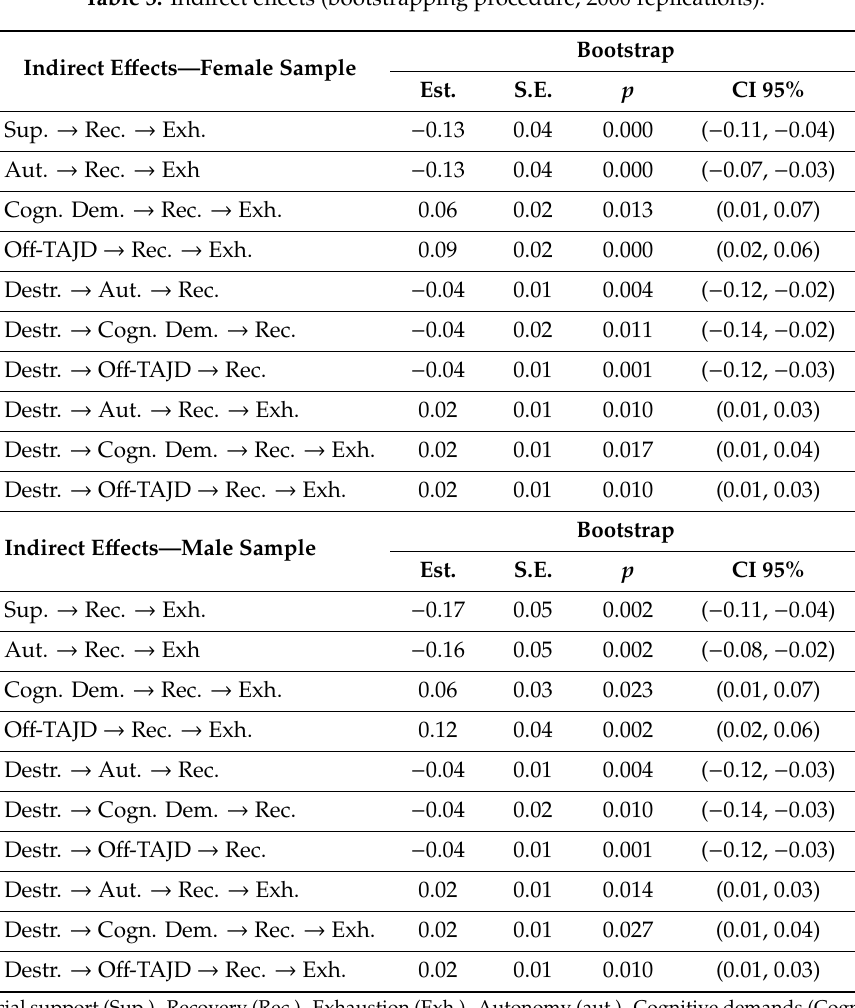
Table 3. Indirect e ff ects (bootstrapping procedure, 2000